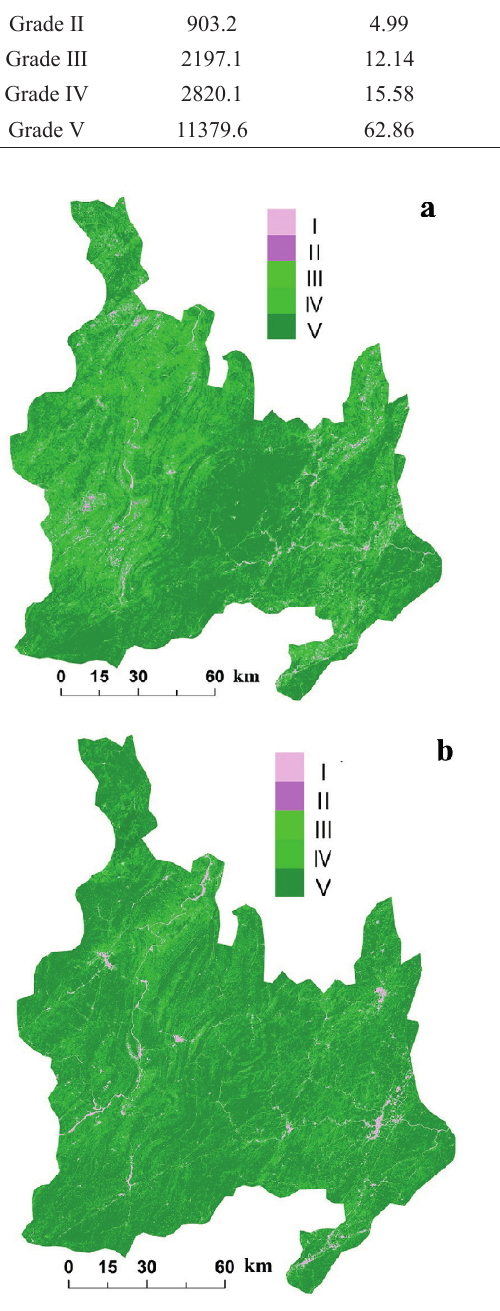
Figure 3 - Vegetation coverage grades of the study area in 2000 ( a ) and 2016 ( b